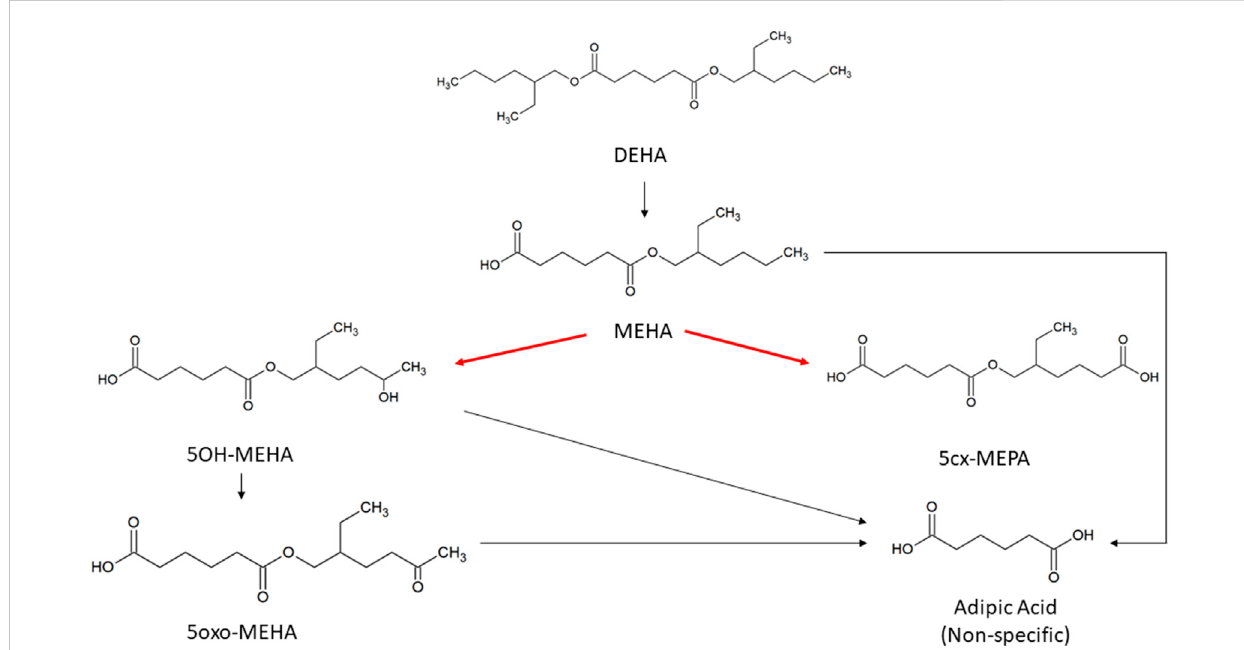
FIGURE 1 Metabolic pathway of DEHA to the speci fi c, side-chain-oxidized monoesters measured in the controlled human exposure study of (Nehring et al., 2020)andsimulatedusingthePBPKmodel.Theintrinsicclearance,Cl int forthebiotransformationofMEHAtothetwourinarymetabolitesisshownbythe red arrow. Cleavage to the non-speci fi c metabolite adipic acid (AA), and phase II metabolism (conjugation with, e.g., glucuronic acid) not shown for simpli fi